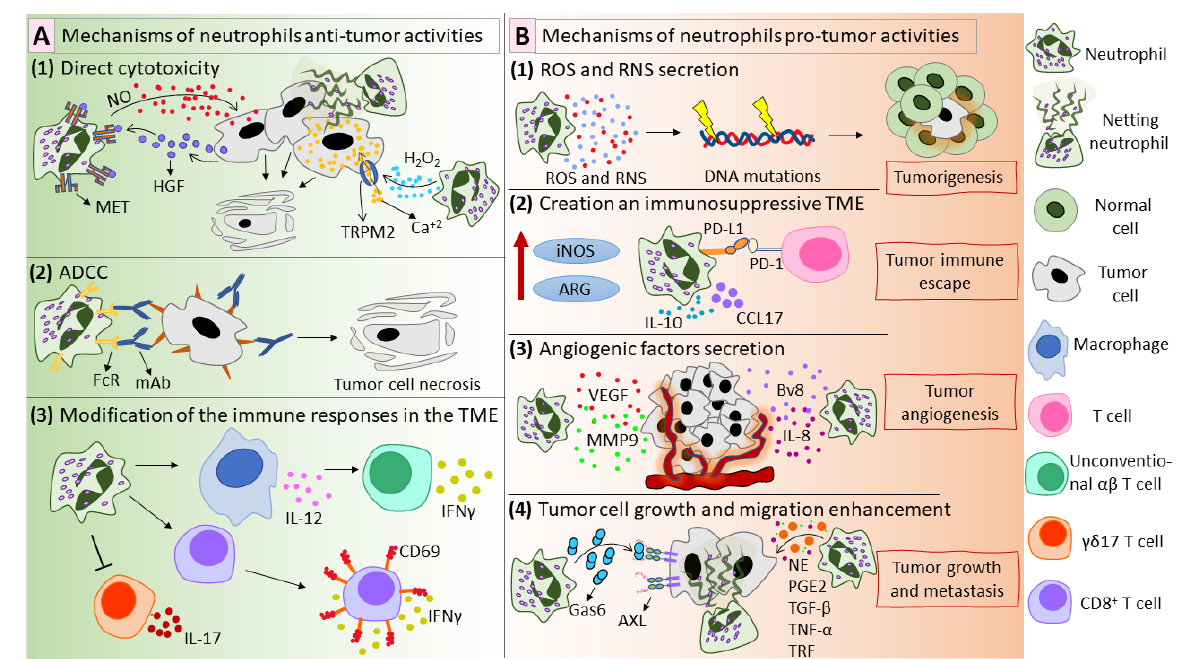
Figure 2. Mechanisms of anti-tumor ( A ) and pro-tumor ( B ) activities of neutrophils. ( A ) Mechanisms of neutrophil anti-tumor activities. ( A1 ) Neutrophils exhibit direct anti-tumor activity via the production of ROS and RNS. Neutrophil-derived H 2 O 2 activates TRPM2 and kills tumor cells in a CA +2 -dependent manner [92]. Tumor-derived HGF interacts with MET on neutrophils and stimulates NO production, which mediates the destruction of tumor cells [93]. Moreover, NETs can display anti-tumor effects [95,96]. ( A2 ) Neutrophils kill antibody-coated tumor cells via ADCC in a mechanism called trogoptosis [101]. ( A3 ) Neutrophils alter the immune responses in the tumor microenvironment. Neutrophils stimulate macrophages to produce IL-12, which leads to the po- larization of CD4 − CD8 − unconventional αβ T cells, which exhibit IFN- γ -dependent anti-tumor activity [104]. Moreover, neutrophils enhance CD8+ T cell reactivity, reflected in CD69 expression and IFN- γ secretion and inhibit γδ 17 T cells [105,106]. ( B ) Mechanisms of neutrophil pro-tumor activities. ( B1 ) Neutrophils produce ROS and RNS, which can cause genotoxicity and contribute to tumorigenesis [110,111]. ( B2 ) Neutrophils participate in creating an immunosuppressive tumor microenvironment by expressing PD-L1 on their surface, producing high levels of iNOS and ARG and secreting immunosuppressive mediators such as CCL17 and IL-10 [28,119–121]. ( B3 ) Neutrophils support tumor angiogenesis via the secretion of several factors: VEGF [24], MMP9 [24], IL-8 [126], and Bv8 [127]. ( B4 ) Neutrophils promote tumor growth and metastasis by producing NE [116], PGE2 [115], TGF- β [137], TNF- α [137], TRF [138], Gas6 [140], and NETs [143]. ROS—reactive oxygen species; RNS—reactive nitrogen species; TRPM2—transient receptor potential cation channel, subfam- ily M, member 2; HGF—hepatocyte growth factor; MET—mesenchymal–epithelial transition tyrosine kinase receptor; NETs—neutrophil extracellular traps; ADCC—antibody-dependent cellular